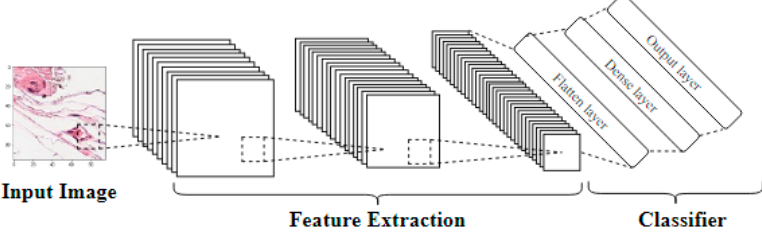
Figure 1. Convolutional neural network (CNN) diagram.